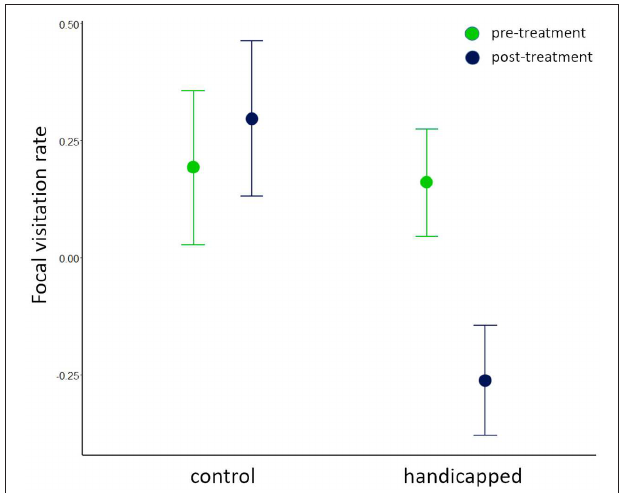
FIGURE 1 | Standardized predicted values ( ± SE) from mixed model of visitation rates of handicapped and control birds. Prior to the treatment, visitation rates did not differ between the control group and treatment group. After the treatment, handicapped birds reduced their visitation